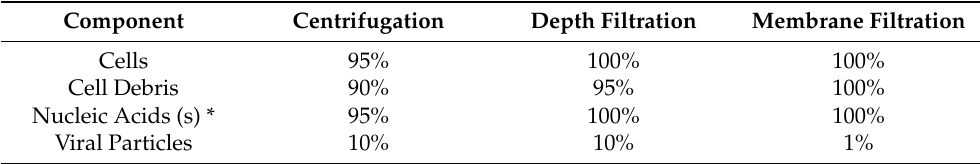
Table 3. Batch process cell lysate clarification performance parameters.